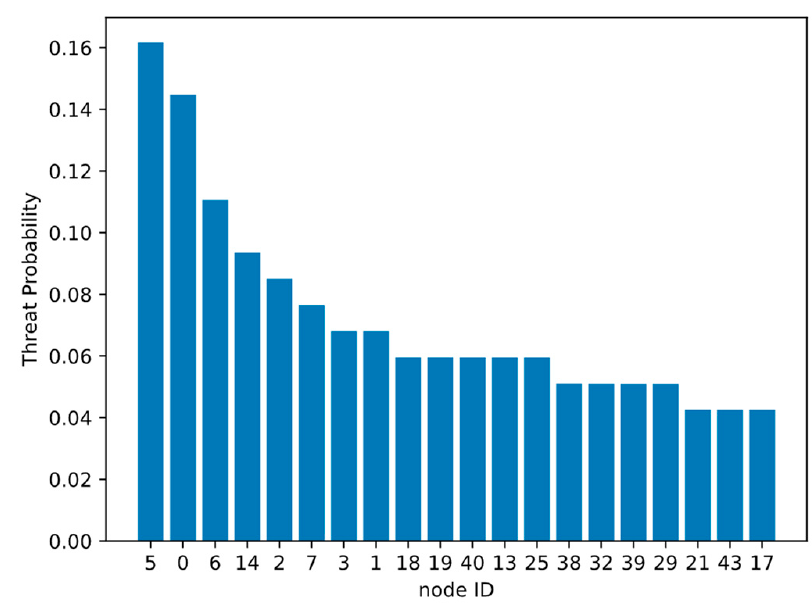
Figure 5. Sequence of high threat-degree nodes (partial).